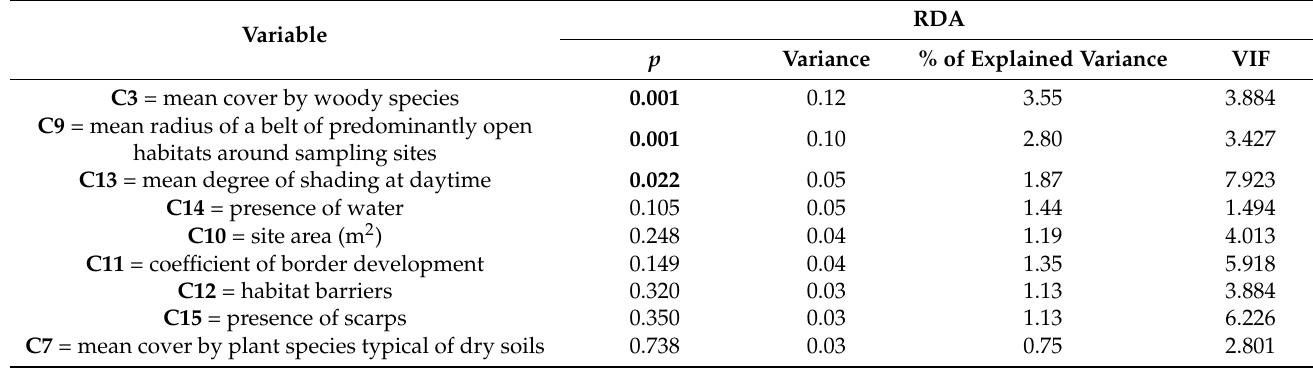
Table 6. Results of stepwise selection of variables and a Monte Carlo permutation test—analysis of significance of effects of the studied variables on occurrence of different species of the Apiformes; variables were considered significant at p <